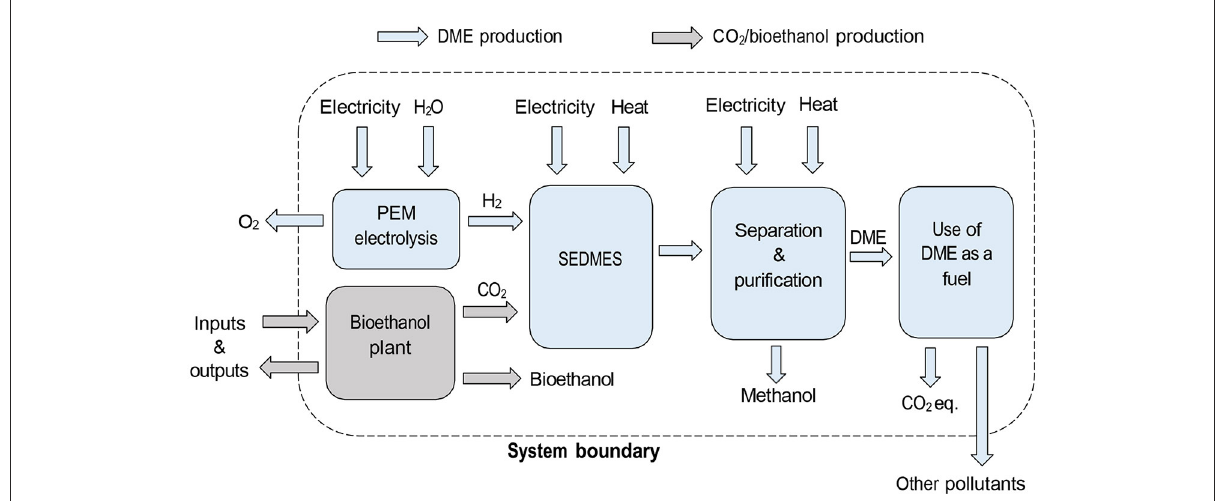
FIGURE1 The study system boundary (represented by the dotted line) when using system expansion to determine the carbon footprint of the Power-to-X DME process when using CO 2 captured from a bioethanol